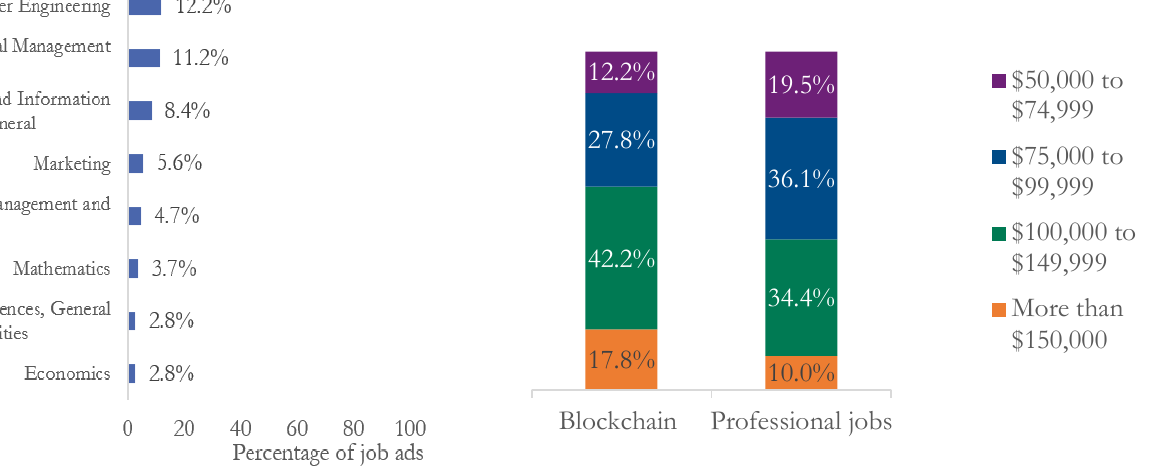
Figure 11. Salary distribution of jobs in blockchain and other Professional jobs between August 2017 and August 2018 (in Australian